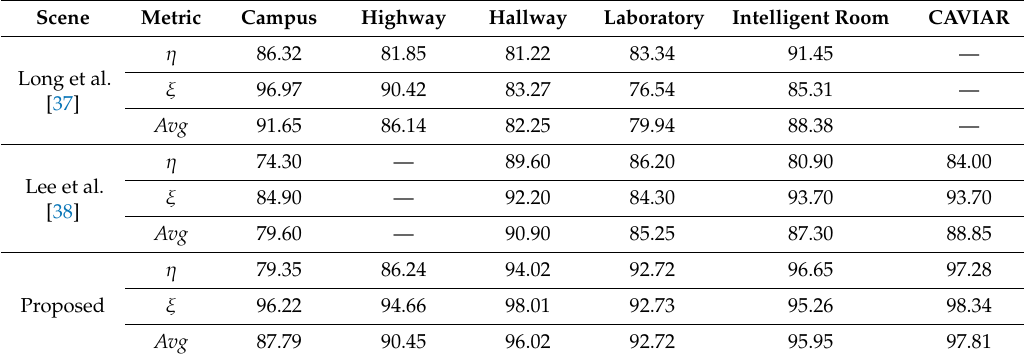
Table 5. Shadow detection comparison results with some representative deep-learning methods.